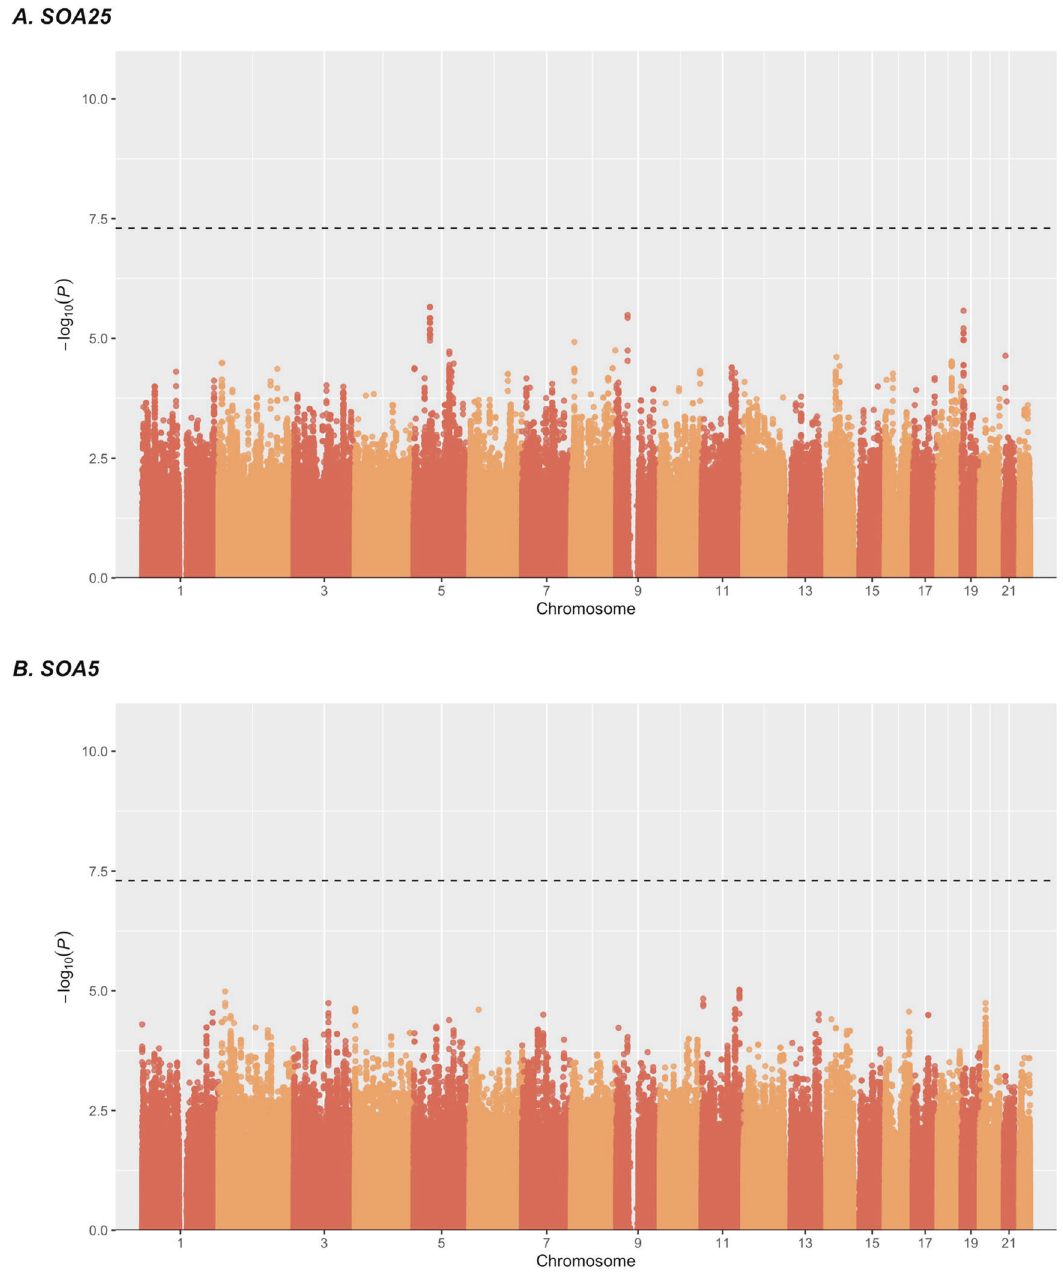
Fig. 5 Manhattan plots. Manhattan plots showing the signi fi cance of association of all SNPs across chromosomes 1 to 22 in the analysis with SOA25 ( A ) and SOA5 ( B ) in 458 individuals. SNPs are plotted on the x-axis according to their position on each chromosome and associations with SOA25 and SOA5 are indicated on the y-axis (as − log10 P value). The dashed horizontal lines mark the genome-wide signi fi cance level of 5e − 08 to be associated with genetics risks for schizophrenia. None of the potential associations between its large range of performance studies took into account the large differences in performance levels and human genetic variants. However, this hypothesis between patients. For the visual backward masking endopheno- turned out to be wrong (Fig. 8). type, we grouped all participants and then determined whether Previous studies have assessed the association between various they belonged to the control group, the relative group, or the endophenotypes of schizophrenia and genetic factors. McDonald patient group, and then investigated whether speci fi c genes were and colleagues [40] used white and gray matter as endopheno- associated with performance on this task. types and associated structural points with genetic aspects in 25 It has been reported that the nicotinic system may be de fi cient patients and 36 of unaffected relatives. They reported that gray in patients with schizophrenia [42 – 44] and studies found a matter in the left temporal regions and in the bilateral fronto- deletion of 15q13.3 (chromosomal location of CHRNA7) [45]. In a striato-thalamic region was associated with genetic risks for previous study, we investigated performance in the visual schizophrenia. In a review, Gur et al. [41], reported a list of cognitive endophenotypes, such as attention or working memory,